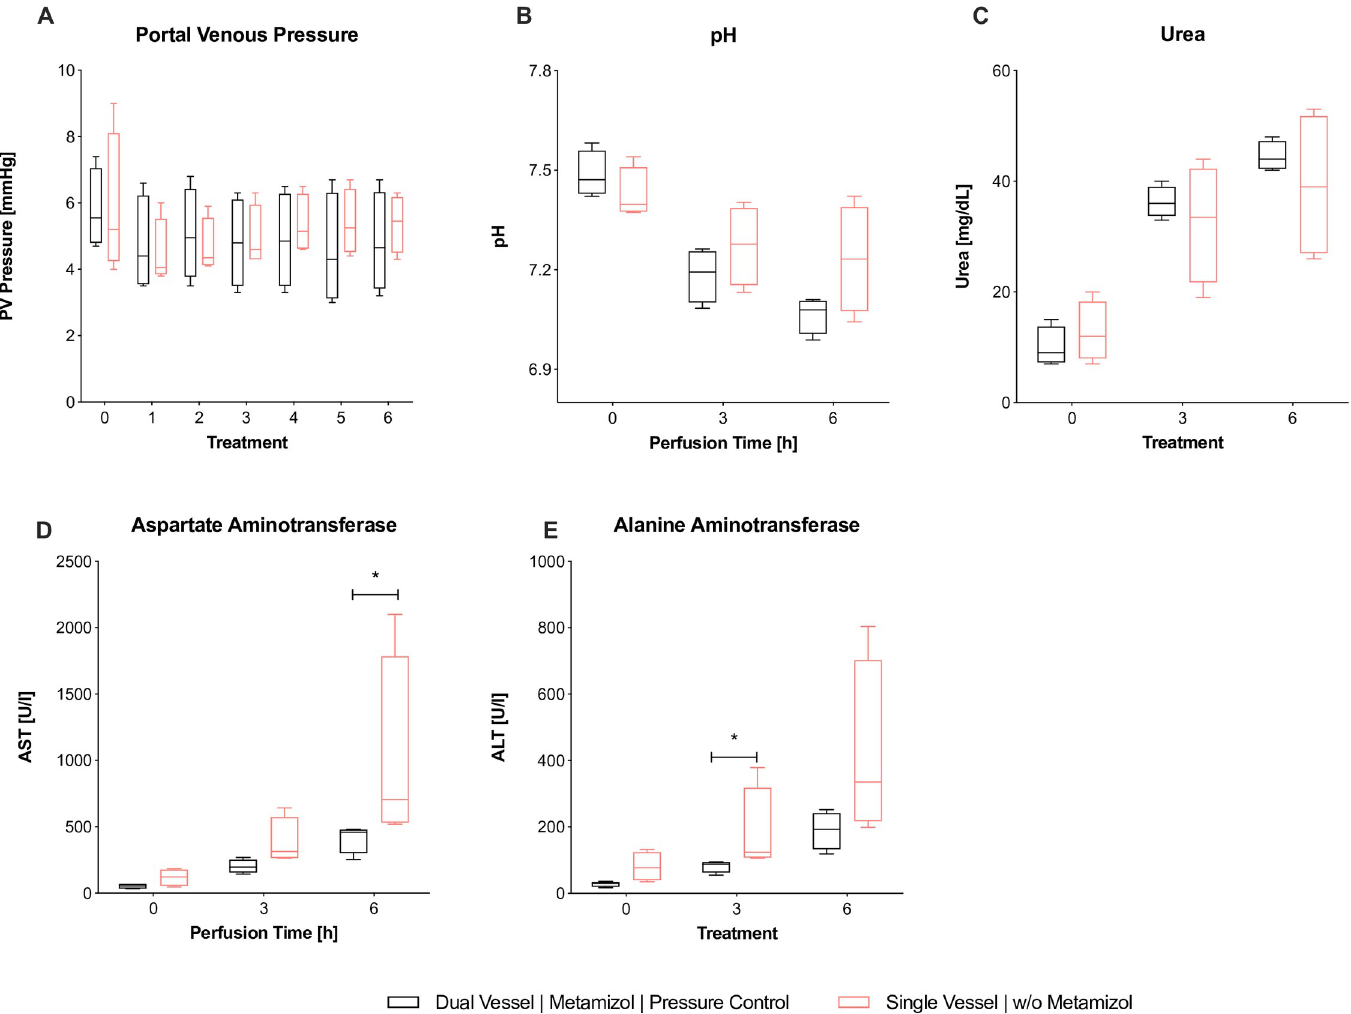
Fig 5. Comparison of dNEVLP MP and sNEVLP groups 1. Comparison of dNEVLP MP and sNEVLP: (A) portovenous pressure; (B) pH of perfusate, (C) urea within perfusate, (D) alanine aminotranferase within perfusate, (E) aspartate aminotransferase within perfusate. � indicates p � 0.05. Data shown as median and interquartile